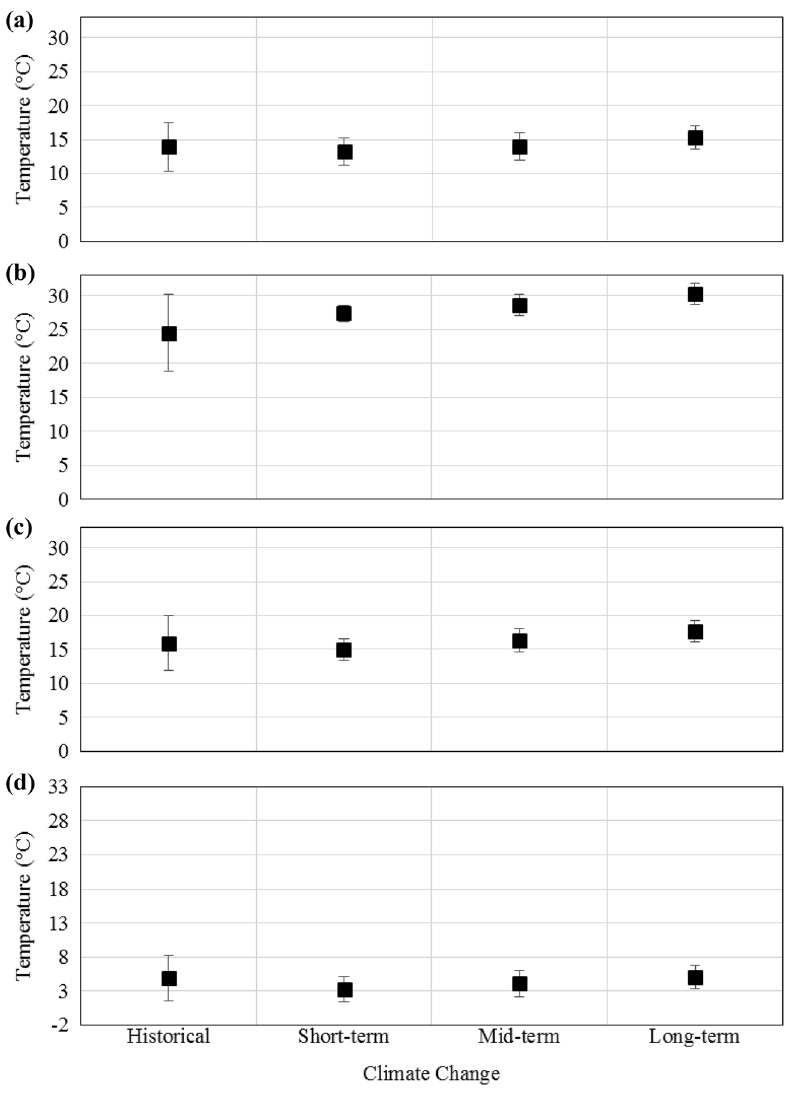
Figure 6. The historical and simulated average temperatures of the entire basin with the 95%confidence interval in (a) spring; (b) summer; (c) autumn; and (d)